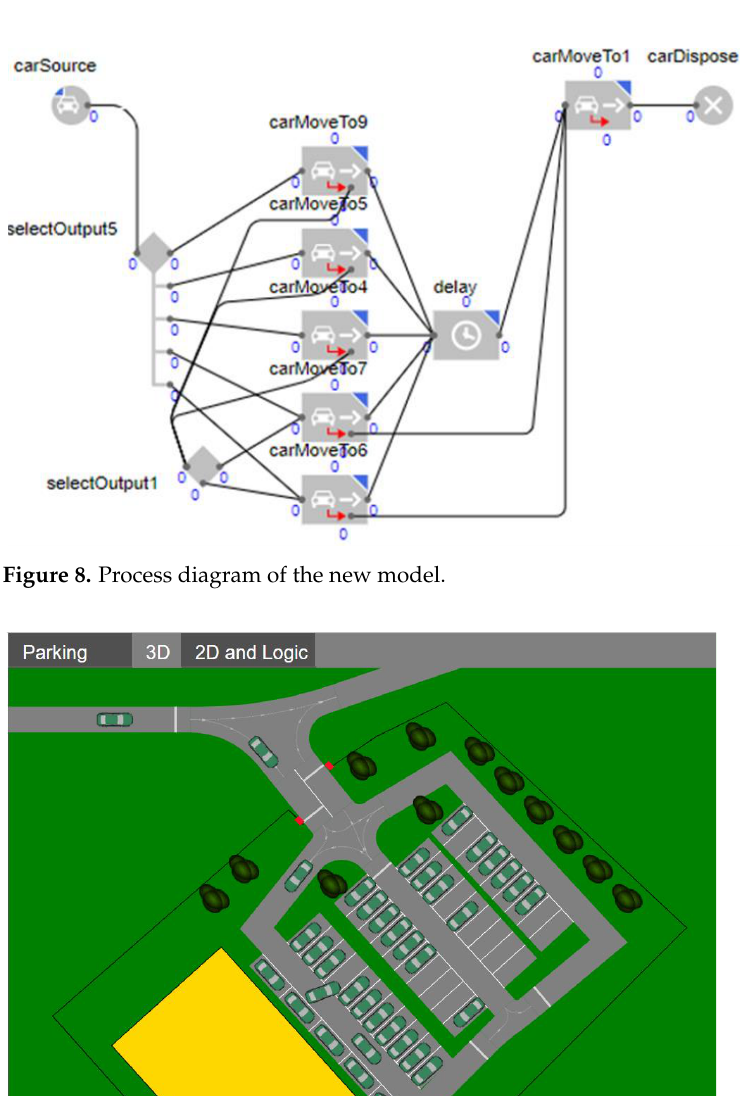
Figure 10. A 3D animation of the new model. An experiment on an improved simulation model (Figure 11), with an implemented access control automation scheme using a client card, showed that the occupancy of the parking lot at the “ peak ” time did not exceed 75%.